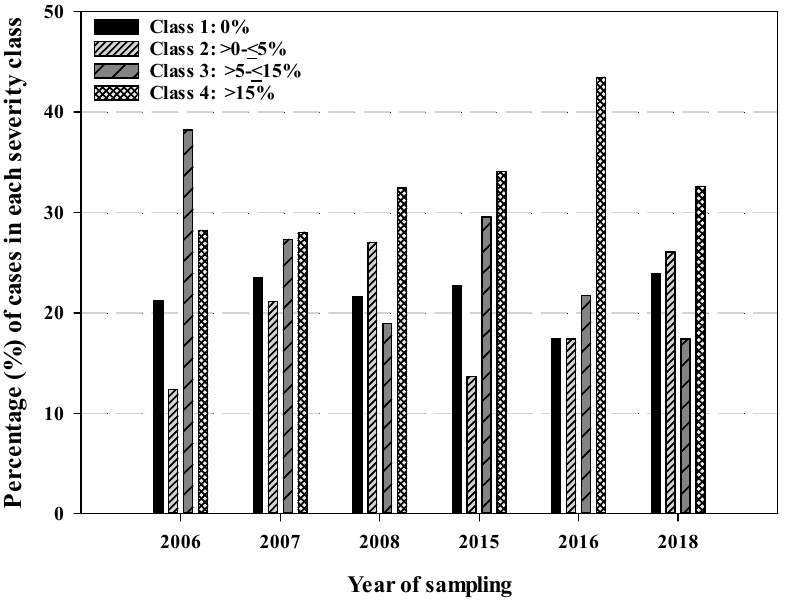
Figure 1. Percentage of cases in each strawberry powdery mildew severity class (1 to 4) for the years of sampling used to develop the trees (2006, 2007, and 2008) and years used for external validation (2015, 2016, and 2018). Disease severity was assessed as the proportion of leaf area diseased on the three youngest fully expanded leaves, mean over 25 plants per site. Strawberry powdery mildew was assessed 170, 289, 222, 44, 46, and 46 times in 2006, 2007, 2008, 2015, 2016, and 2018, respectively.